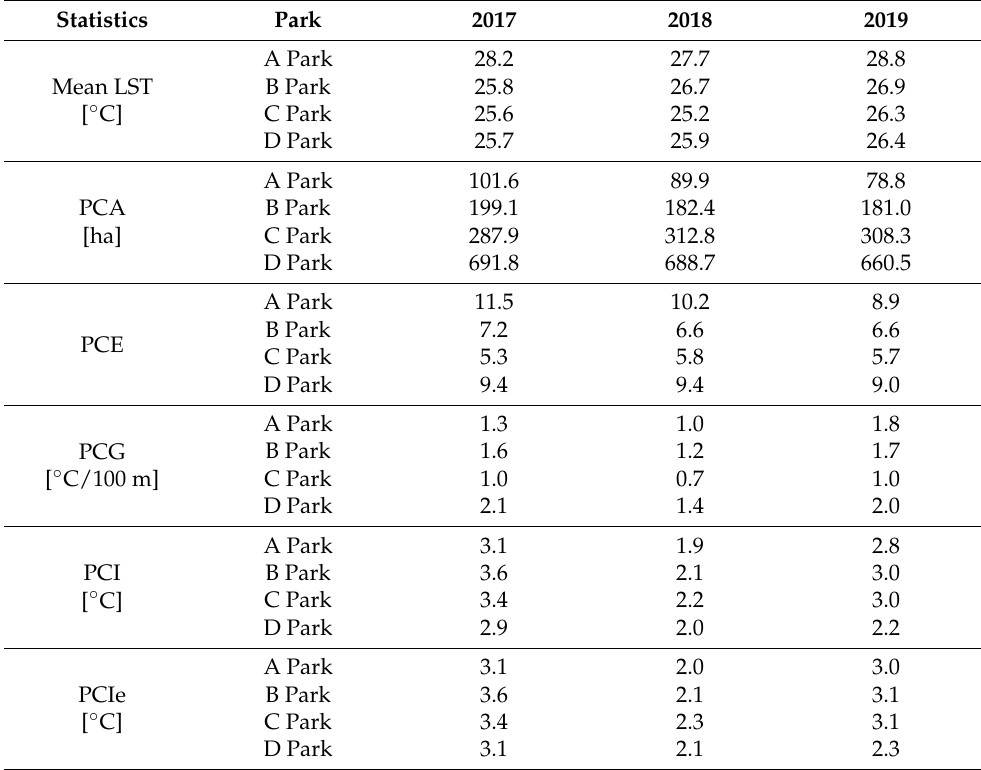
Table 3. Mean park LST and spatial statistics of urban park effect on